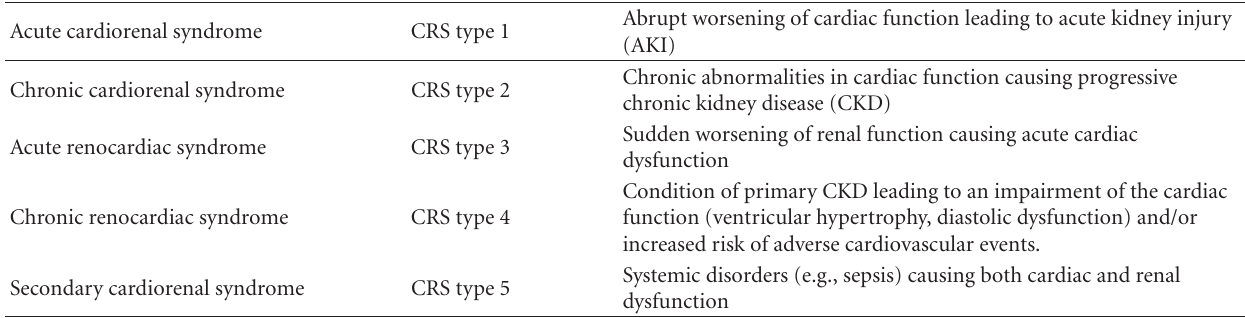
Table 1: Classification of cardiorenal syndorme